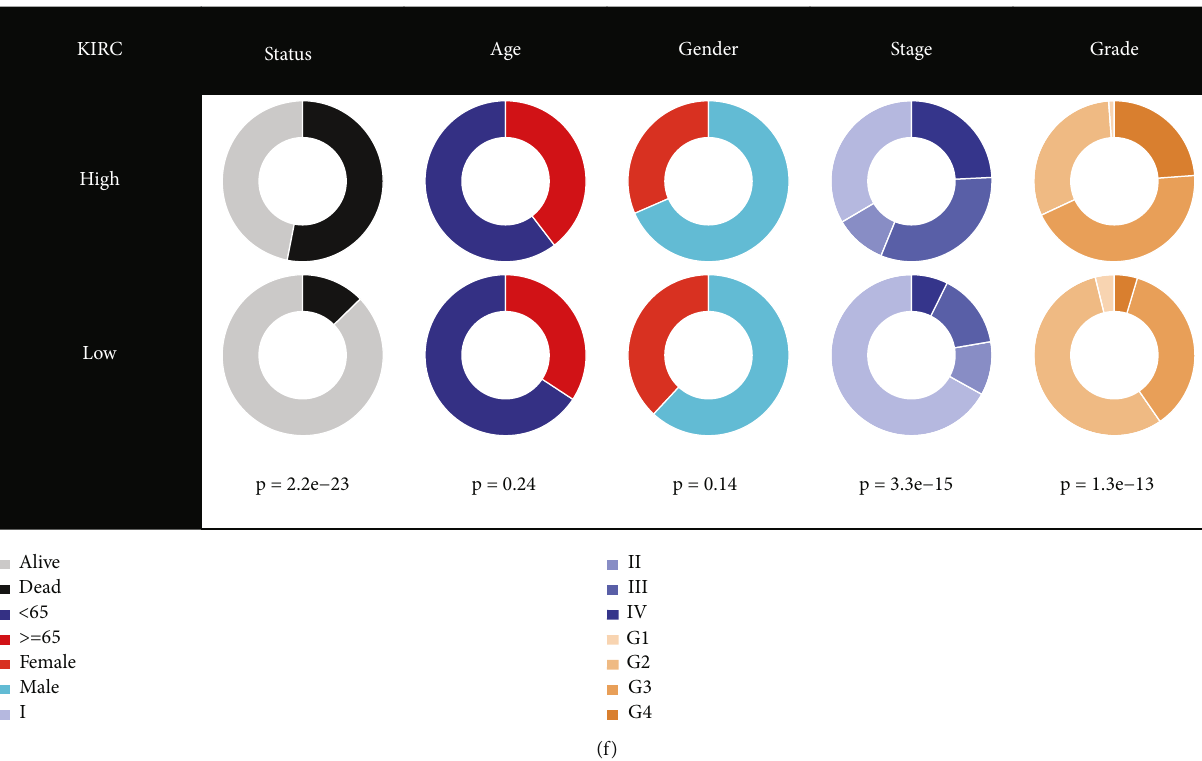
Figure 5: Establishment of the clinical nomogram. (a) The “ Sanky ” plot of the association among patient survival status, clusters, and risk groups. The forest plots of the clinical features were fi ltered by the univariate (b) and multivariate (c) Cox regression. (d) Constructed clinical nomogram consists of age, stage, grade, and risk score for predicting patient overall survival. (e) Calibration curve for validating the calibration of the nomogram ’ s predictive ability for patient survival. (f) The di ff erences in the clinical features between the low-risk and high-risk